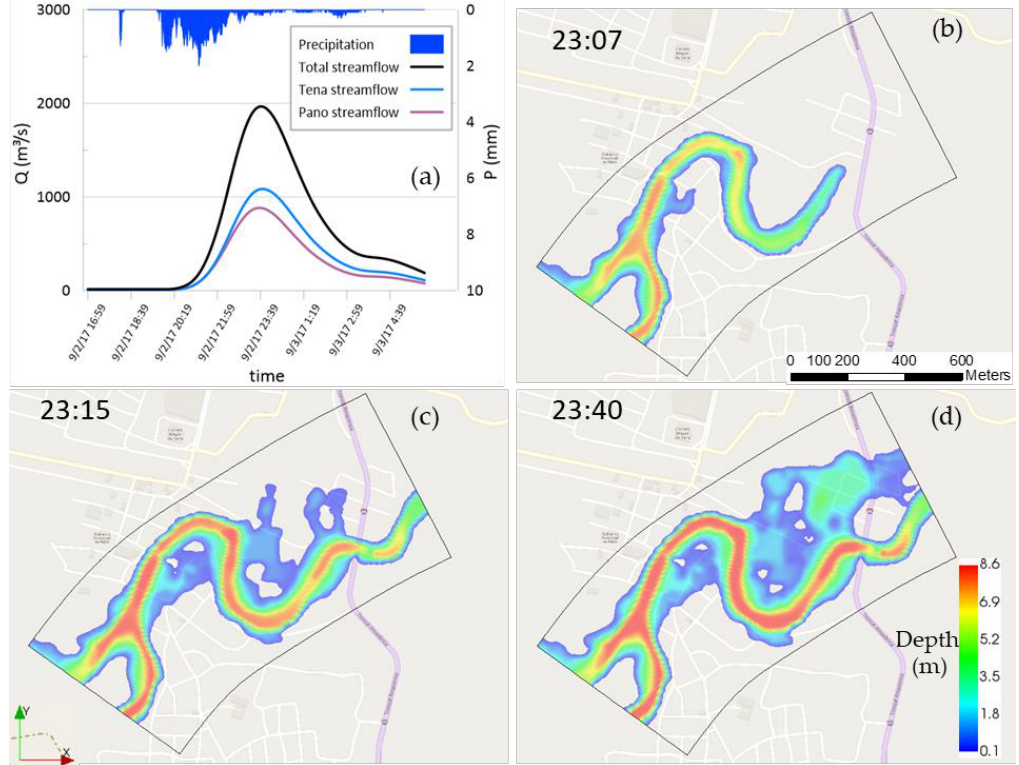
Figure 6. Spatio-temporal evolution of the flood event generated by the 500-year storm on 2 September 2017. ( a ) HEC-HMS-reconstructed hydrograph. Flood stage ( b ) at the beginning of the river overflow, ( c ) when the overflow took place along several river segments, and ( d ) at the time of peak flow.